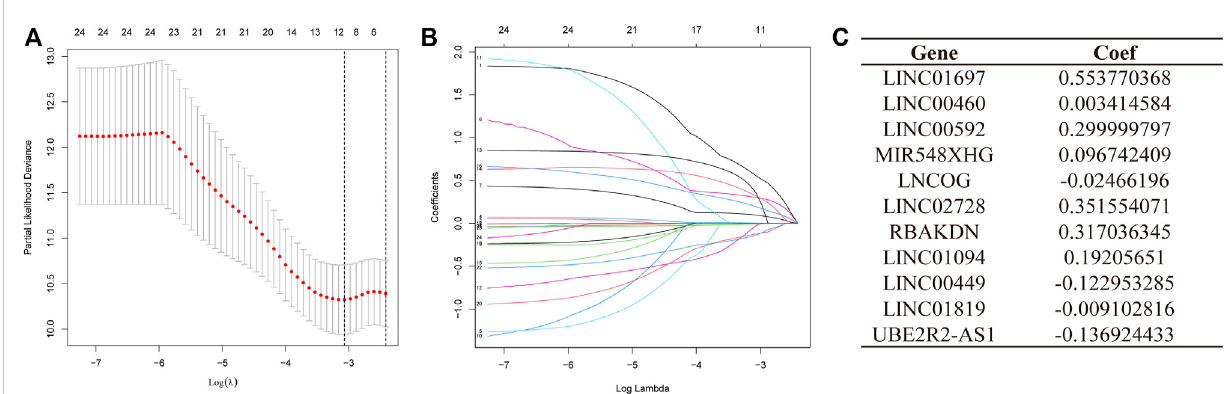
FIGURE 3 LASSO Regression for STAD Patient Risk Models Based on AMMLs. (A) 10-fold cross-validation of variable selection in LASSO models. (B) The distribution of LASSO coef fi cients for 11 AMMLs. (C) 11 characteristic AMMLs and their correlation coef fi cients. LASSO, Least absolute shrinkage and selection operator; STAD, Stomach adenocarcinoma; AMMLs, Amino acid metabolism-related LncRNAs.